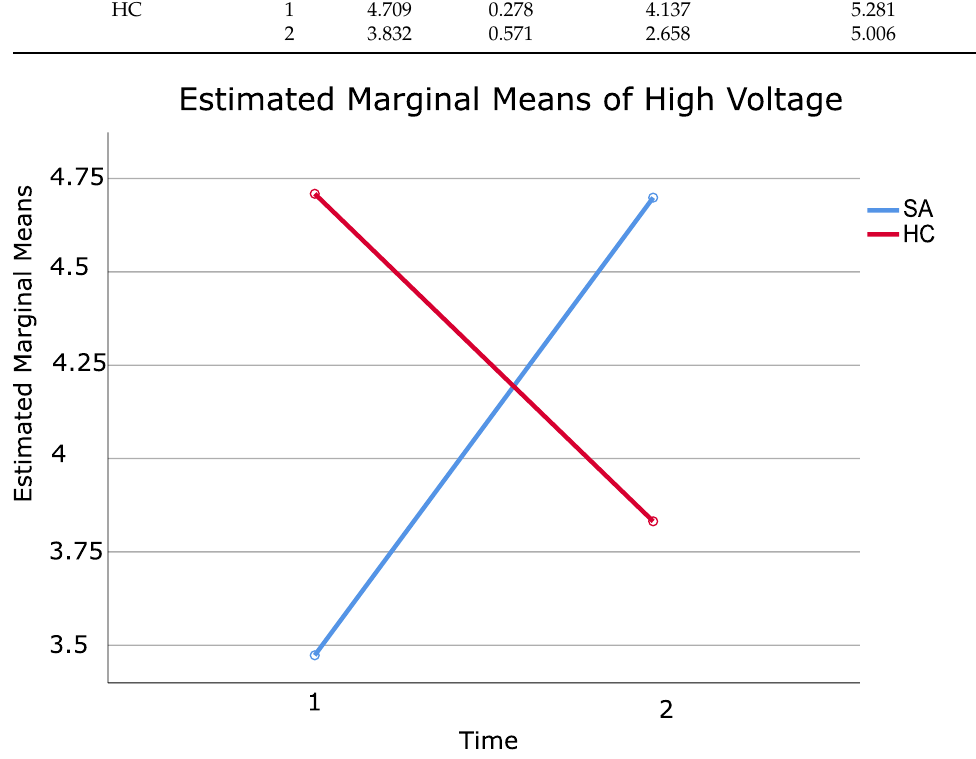
Figure 5. Displayed means for high voltage measured at Time 1 (baseline) and Time 2 (after 20 sessions of LTH) for SA (shown in blue color) and HC (shown in red color) groups. However, no statistically significant effect was seen for Groups F (1.26) = 0.17, p = 0.68, Eta-squared = 0.007, where the obtained values for SA patients (m = 4.09) were no different form the ones obtained for HC (m = 4.27). Additionally, the effect of Time was not statistically significant either F (1.26) = 0.22, p = 0.64, Eta-squared = 0.009. The mean value of high voltage for SA patients (m = 4.09) compared to HCs (m = 4.26) were alike. Examination of the cell means indicate that qEEG values of high voltage obtained at base- line, and after the complete cycle of LTH only presented a statistically significant Time × Groups interaction. Table 12 contains the descriptive statistics of high voltage of SA and HC groups, before and after the LTH